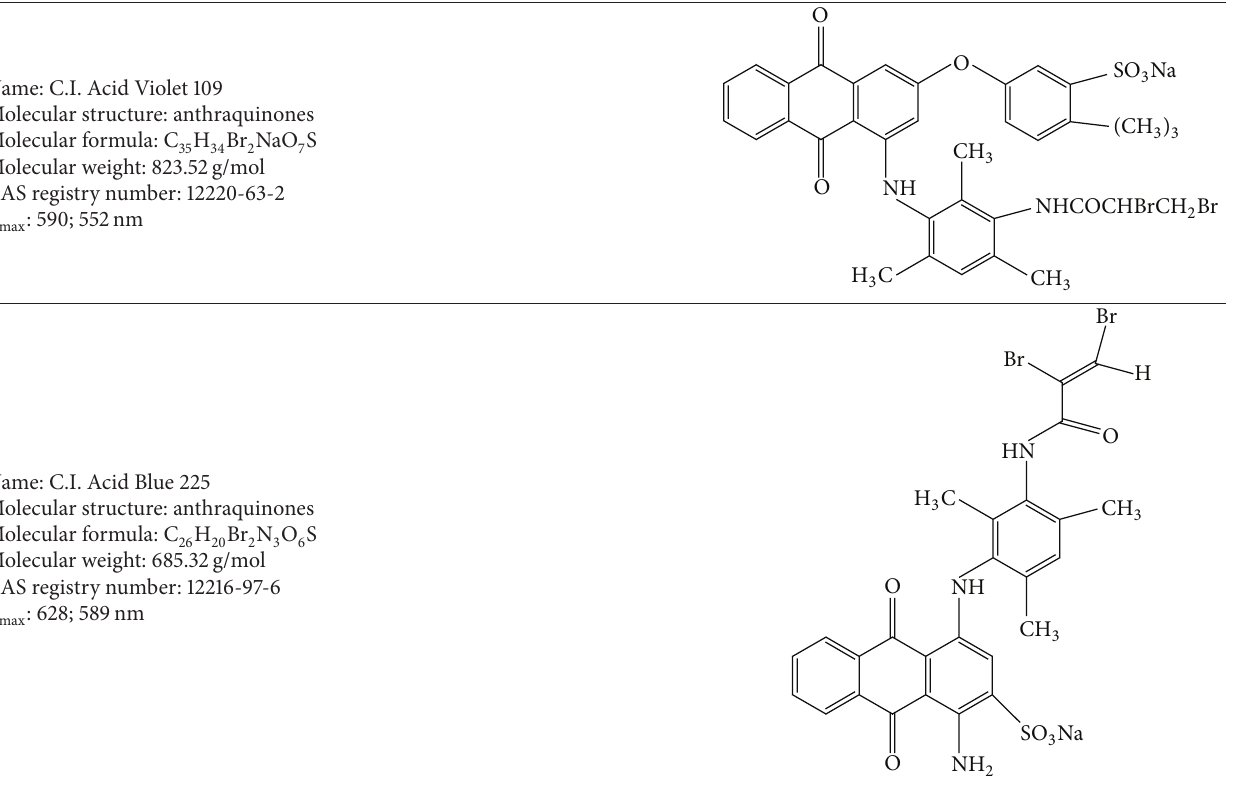
Table 1: Analyzed anthraquinonic dyes properties.